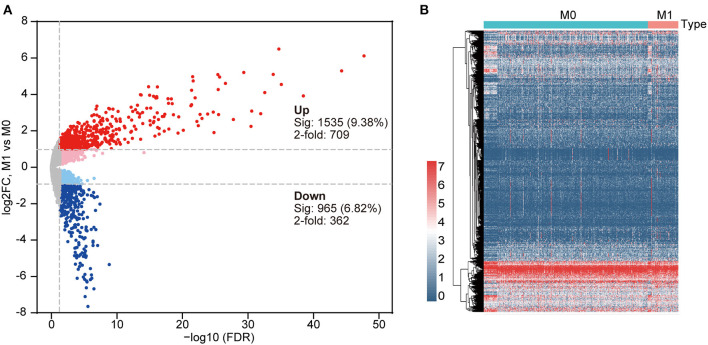
(A) Volcano plot indicating differentially expressed genes (DEGs) in primary COAD patients and metastatic COAD patients (light red and blue colors indicate adj. p < 0.05 (sig), whereas red and blue further require more than a 2-fold change); other genes are colored in gray. (B) Clustered heat map of DEGs in primary COAD patients and metastatic COAD patients. Red, higher expression. Blue, lower expression.